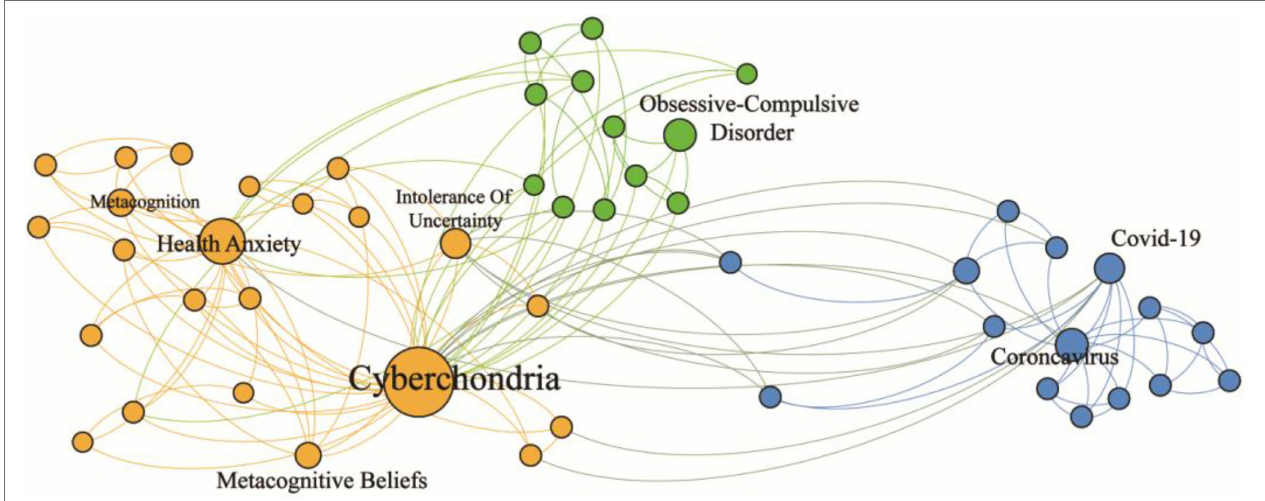
FIGURE 2 | Co-occurrence network diagram of paper keywords related to cyberchondria. Figure shows a core subgroup of 50 nodes, whereby nodes represent keywords of articles and edges represent the connection between two keywords that appear in the same article. Data sources are from 27 included articles, including 84 nodes and 197 undirected edges. The size of a node represents the weight of the edge. Gephi, a network graph software, was used to map the relationships between these keywords. As shown in this figure, existing studies examine cyberchondria under its associations with the ongoing